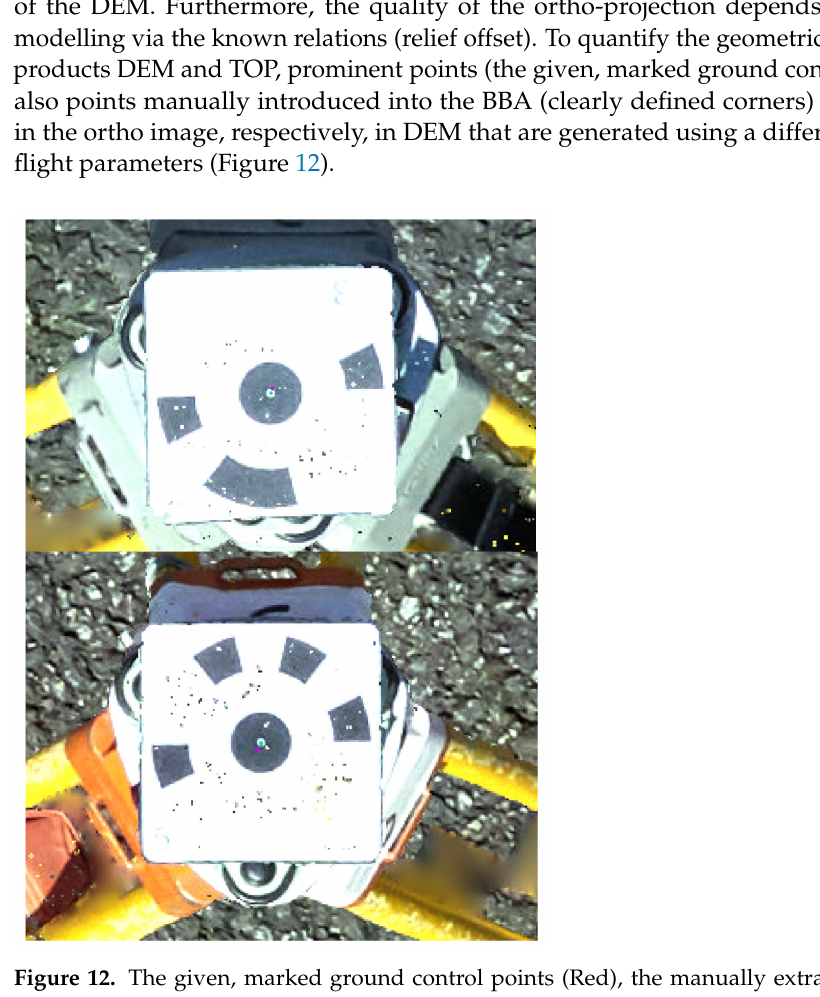
Figure 12. The given, marked ground control points (Red), the manually extracted points from orthophoto and DEM